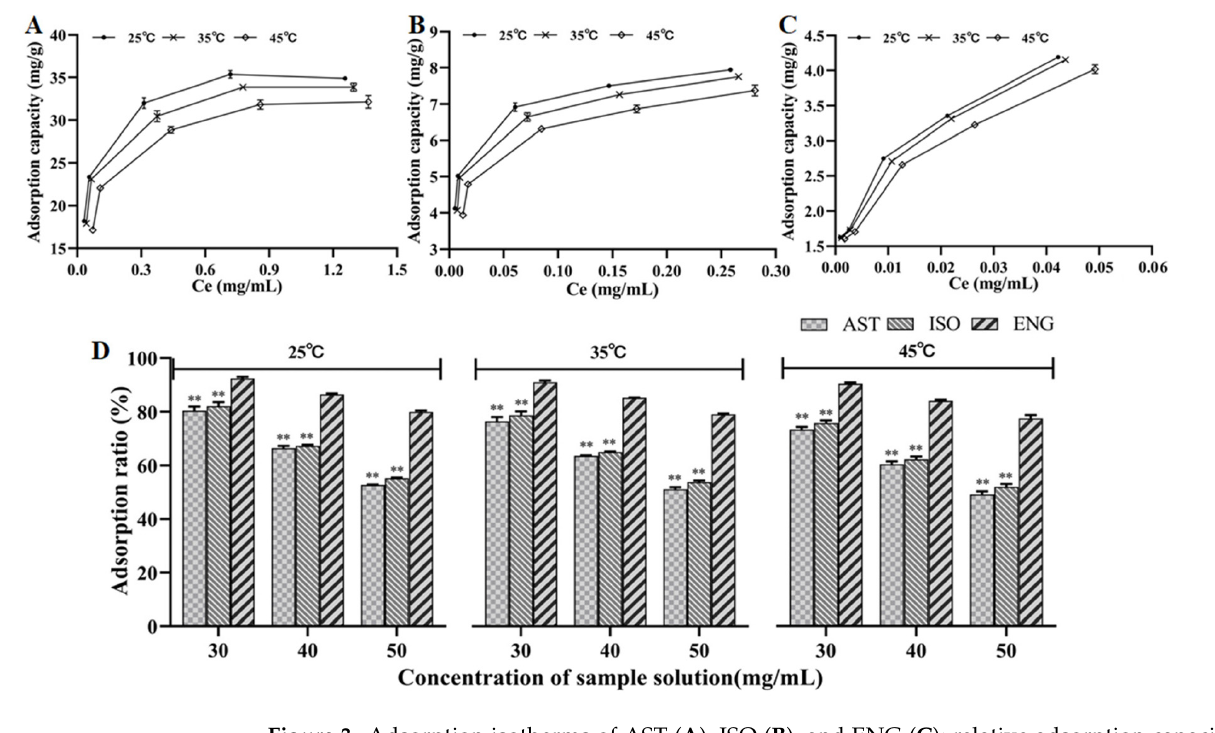
Figure 3. Adsorption isotherms of AST ( A ), ISO ( B ), and ENG ( C ); relative adsorption capacities of the three flavonoids at different temperatures and concentrations (** p < 0.01 compared with ENG) ( D ).